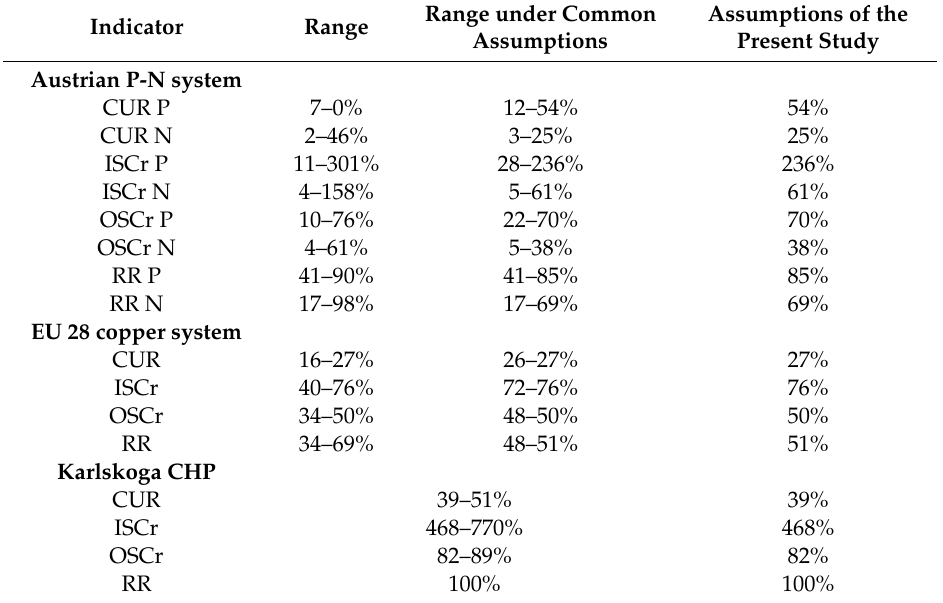
Assumptions of the Present